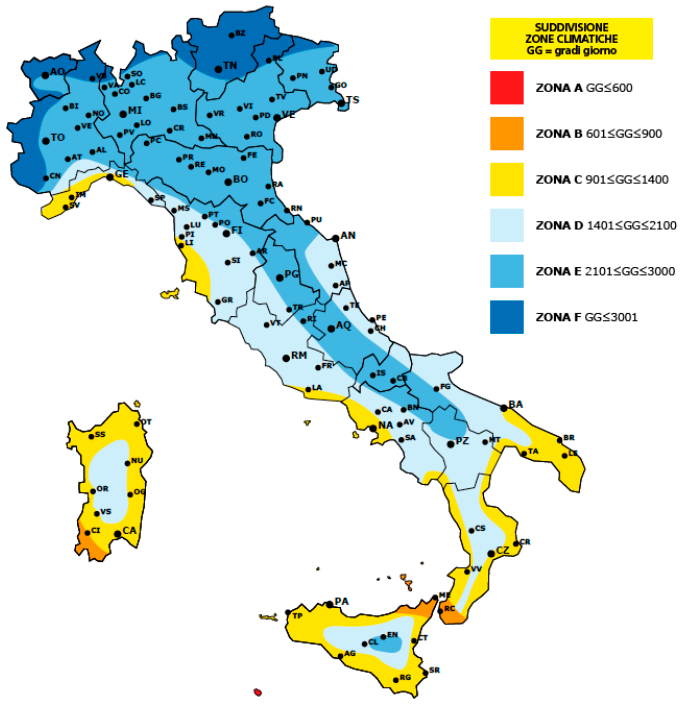
Figure 1. Climatic zonation according to the Presidential Decree 412/93 [40].